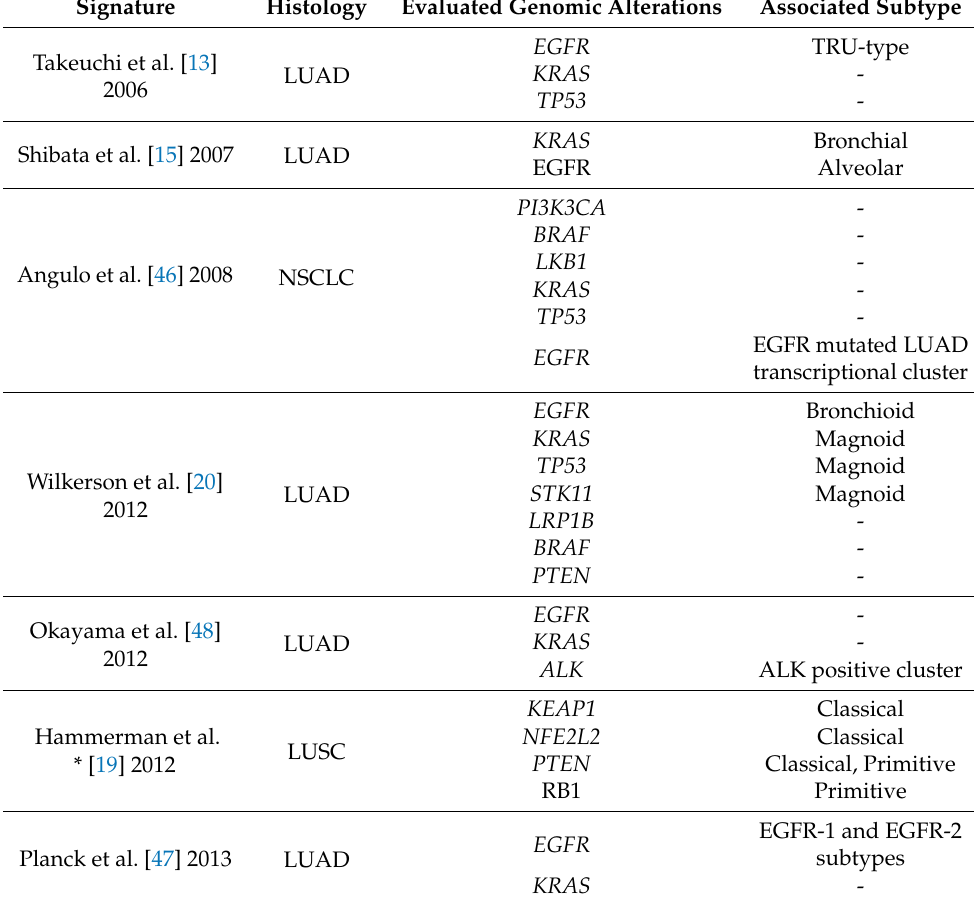
Table 2. Studies concerning the association between genomic alterations and specific transcriptional profiles. * Studies with * had whole-exome sequencing data, and as a wide range of mutations were evaluated with this technology, only the most relevant ones were reported on this